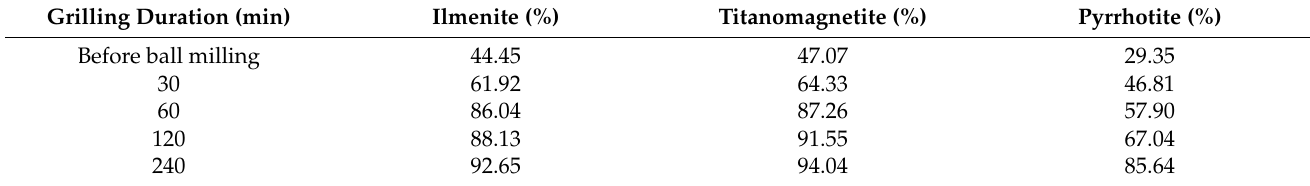
Table 11. Influence of the duration of the grinding process on the dissociation degrees of mineral monomers.